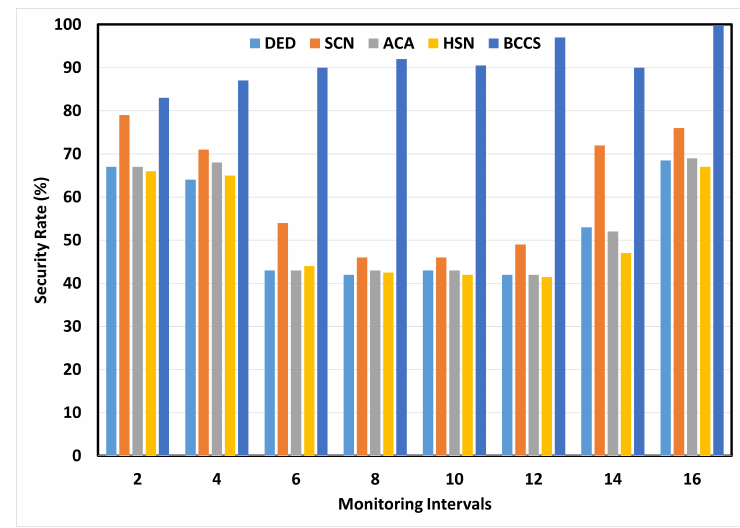
Figure 9. Security rate (monitoring intervals).